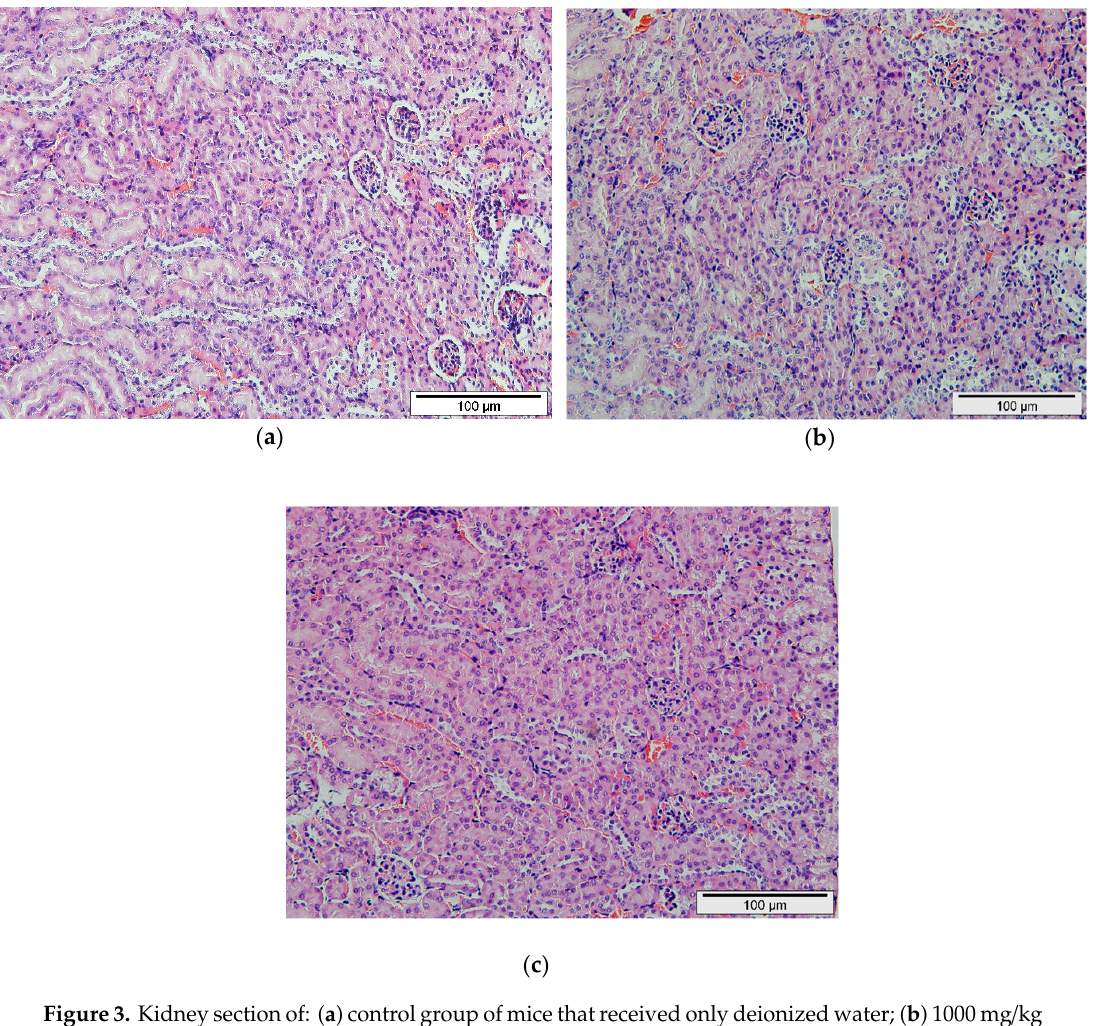
Figure 3. Kidney section of: ( a ) control group of mice that received only deionized water; ( b ) 1000 mg/kg of IP 6 -CS-MNPs; ( c ) 2000 mg/kg of IP 6 -CS-MNPs (H&E stain, ×100).